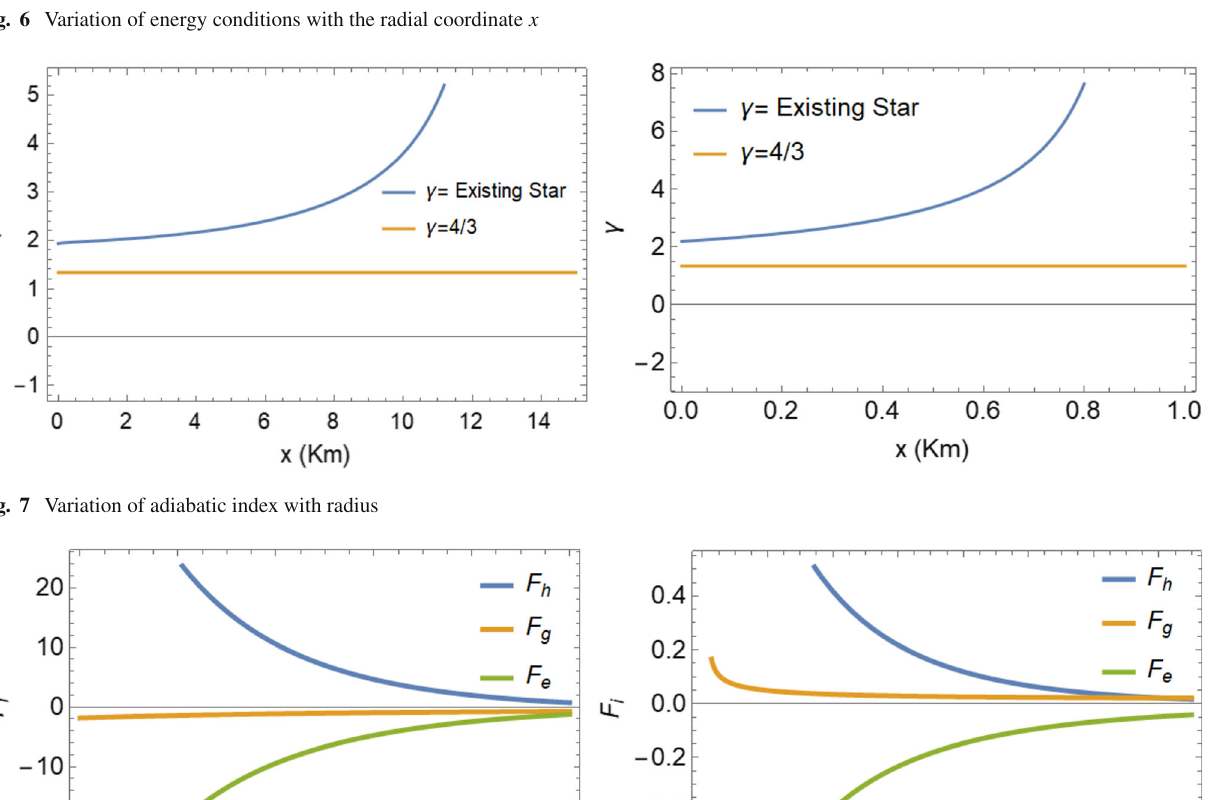
q ( x ) vanishes at the centre, remains continuous